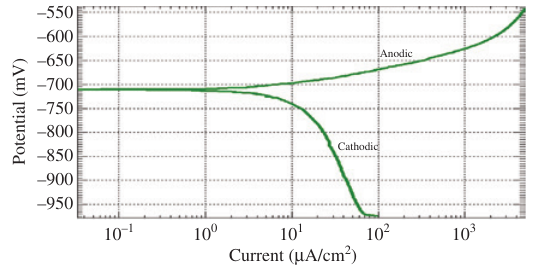
Figure 11: Tafel polarisation curves for high strength aluminium alloy in a 3.5 wt.% NaCl solution.